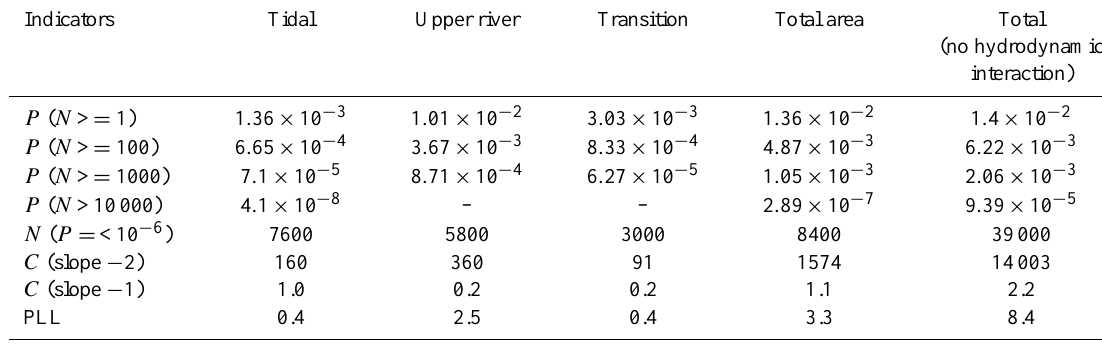
Table 1. Indicator values derived from the FN curve for the three subareas and the total area.